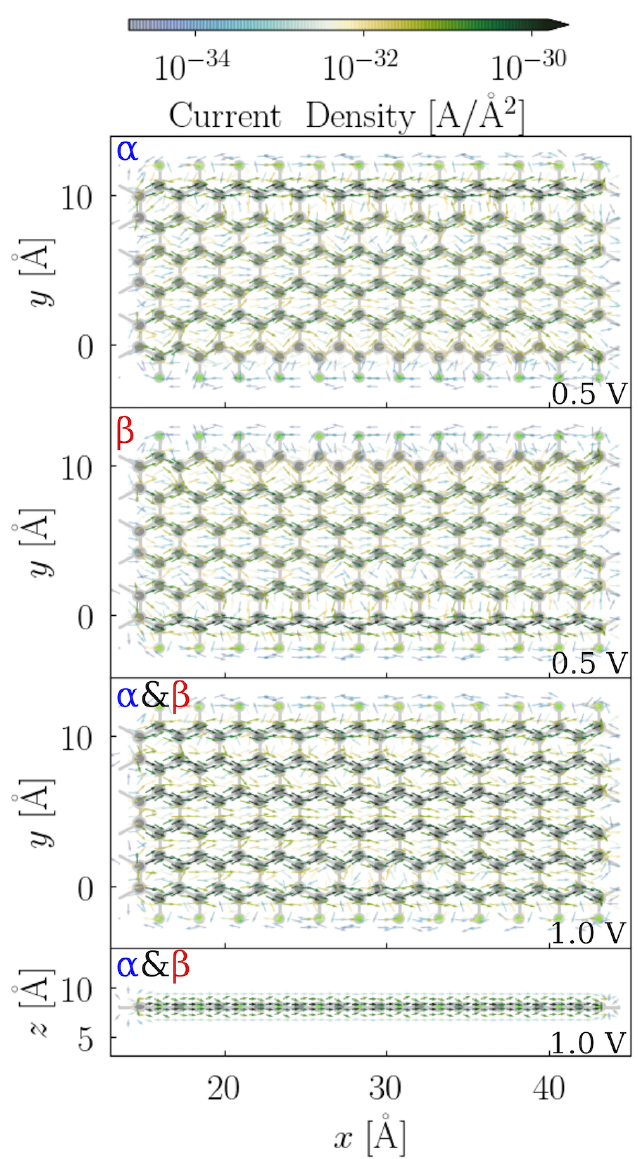
Figure 7. Quiver plot of the electronic current density projected on the real space of the scattering region of F-6Z. The grid spacing is chosen as 1 atomic unit in the volume of the cell cartesian coordinates. The bias voltage along the x -axis of the nanojunction plane is applied. The upper two panels illustrate the α and β spin channels at 0.5 V bias voltages, respectively, whereas the lowest two panels denote both α and β spin channels at 1 V. For simplification, the flux density is integrated along the z -axis of the nanojunction plane for the top view, and along the y -axis for the side view. The intensity of the current density is illustrated according to the color bar, where green indicates the high intensity and blue presents the low